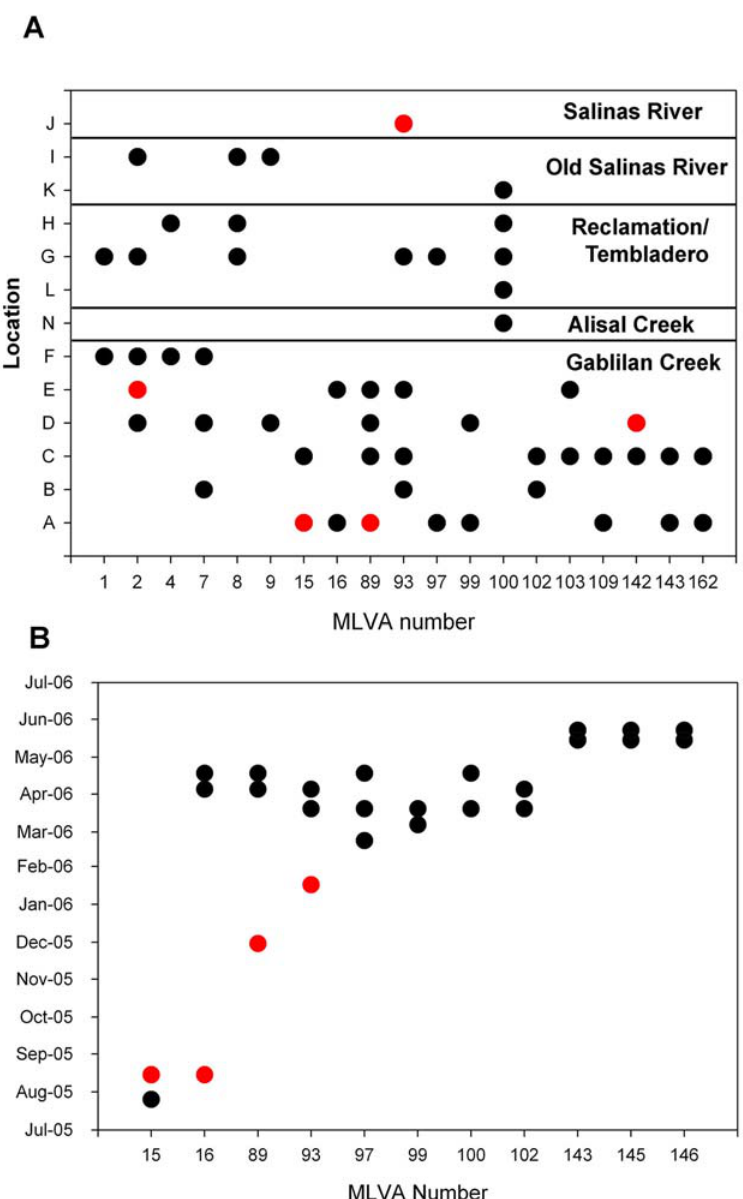
Figure 5. MLVA types compared to (A) Salinas watershed location or (B) sample date. Location designations refer to Figure 1 and are separated by horizontal lines in (A) to indicate separate waterways. Black and red dots indicate isolation of the MLVA type at the indicated location or date. Red dots indicate that differences were detected between that isolate and the other isolates of that MLVA type by PFGE.